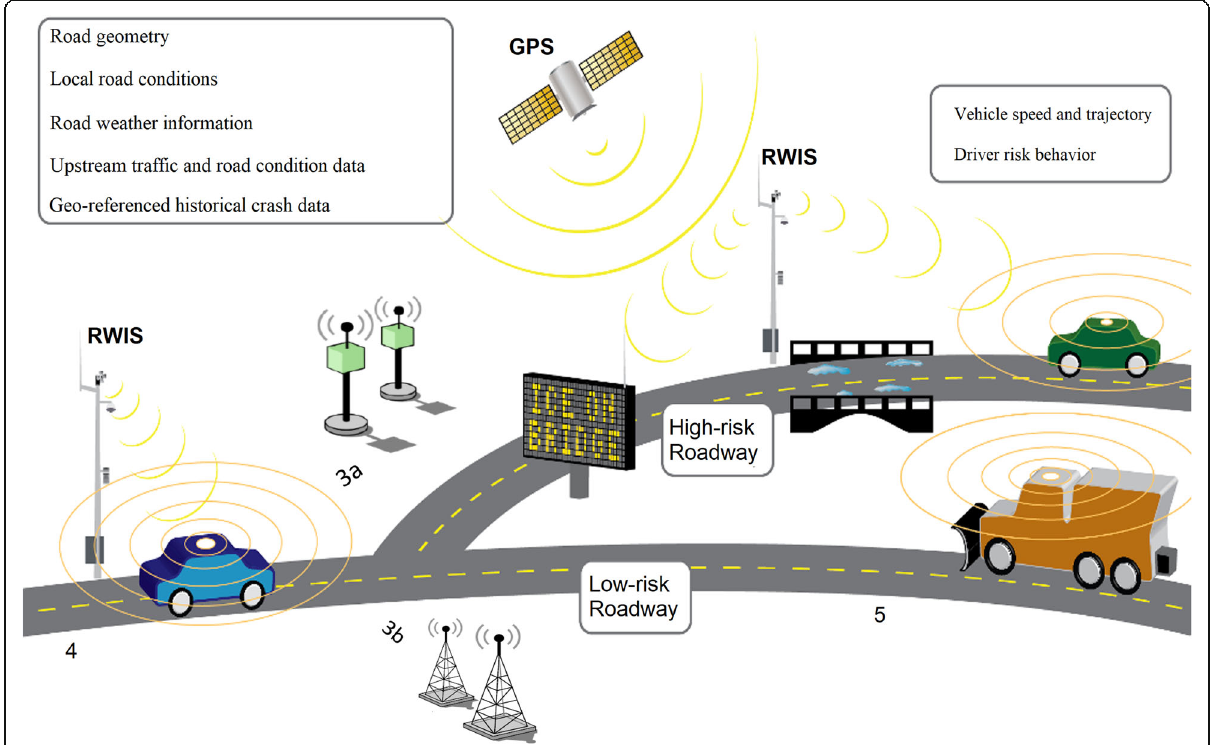
Fig. 1 Conceptual design of next-generation highways in cold climates. Application scenarios include safety applications (e.g., blind spot warning and collision warning) and mobility applications (e.g., traveler information, routing support, and coordinated truck platooning [not